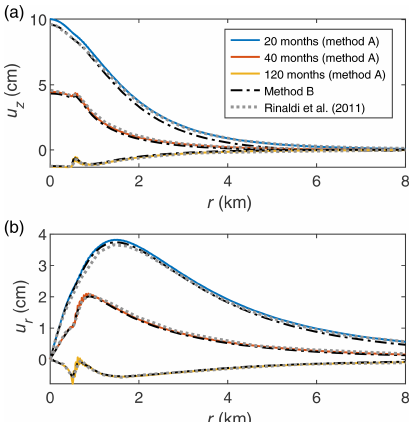
Figure 8. Radial distribution of the vertical (a) and horizontal (b) ground displacement at sequential times. The coloured and dash- dotted lines correspond to methods A and B, respectively.